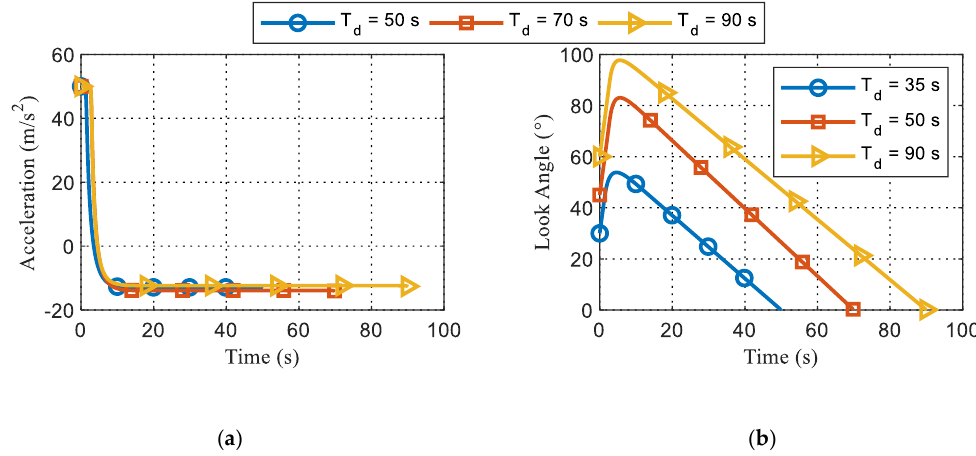
Figure 16. The results for a moving target. ( a ) Command acceleration; ( b ) Look angle.